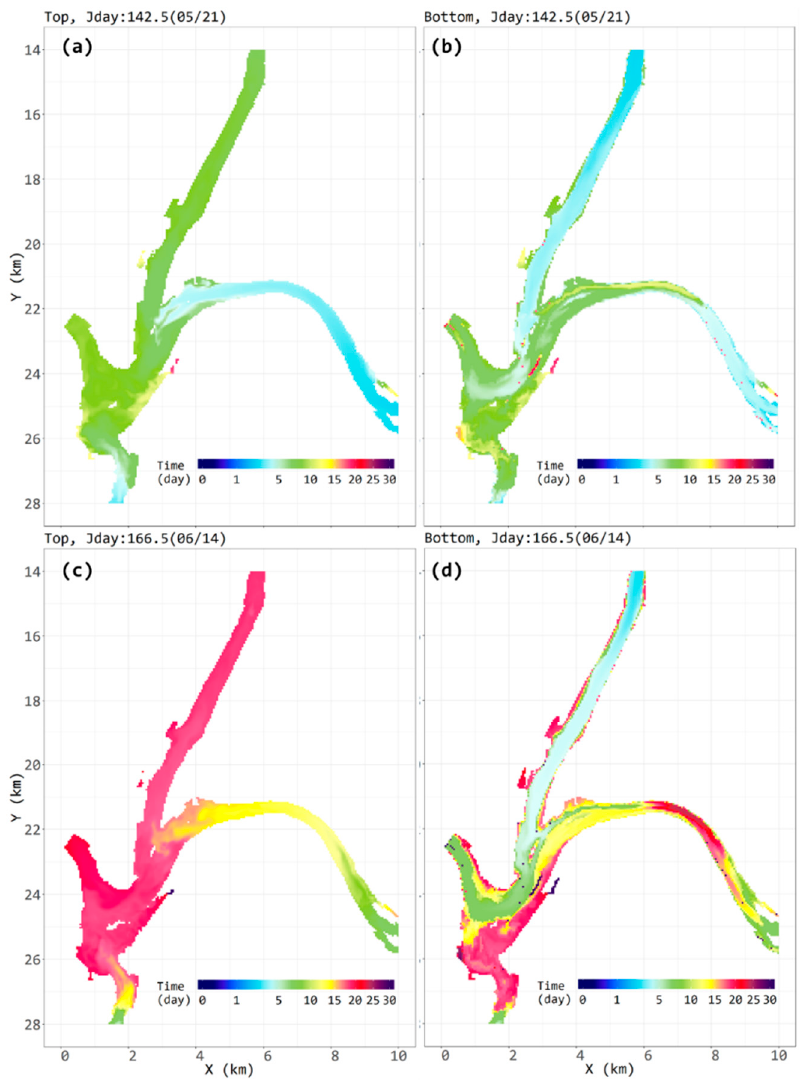
Figure 7. Horizontal variations of water age on Julian day 142.5 ( a , b ) and 166.5 ( c , d ). Left ( a , c ) and right ( b , d ) snapshots present the top and bottom layers. Jday and parentheses are the Julian day of year in 2016 and month/day (format: mm/dd).